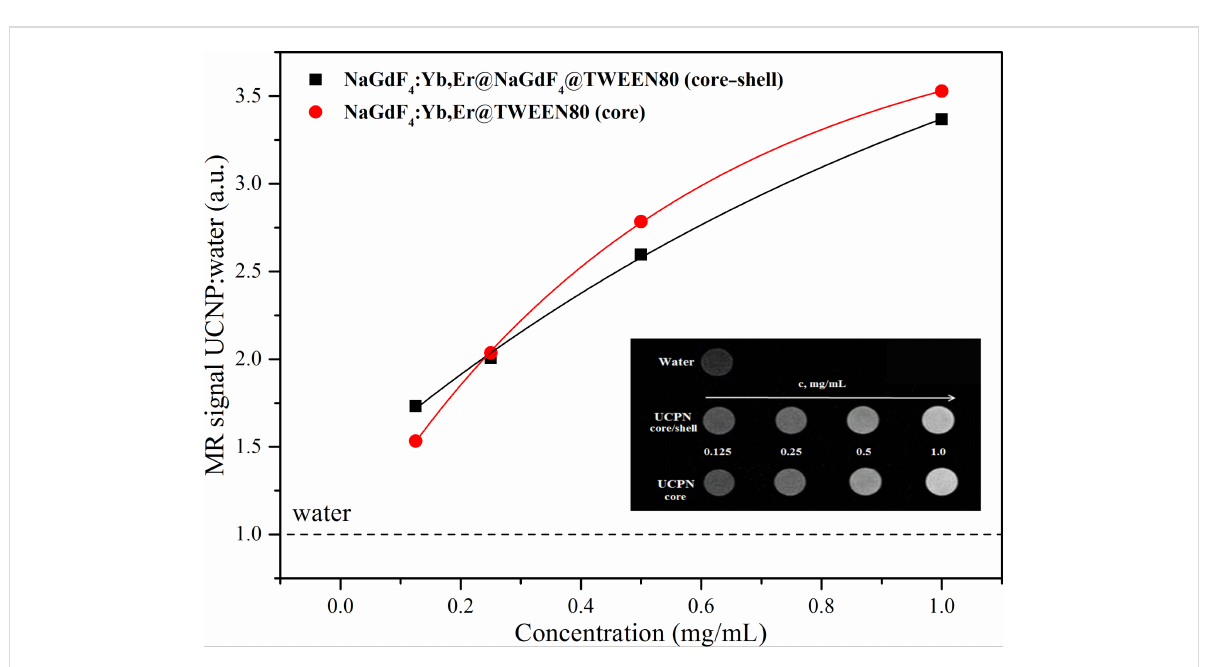
Figure 5: Magnetic resonance (MR) signal intensity (SI) plot of core (red dots) and core–shell (black squares) UCNPs of different concentrations of aqueous solutions. Water SI is marked as a dashed line as a reference; Inset: T1-weighted MR in vitro images of core and core–shell UCNPs at dif- ferent concentrations of aqueous